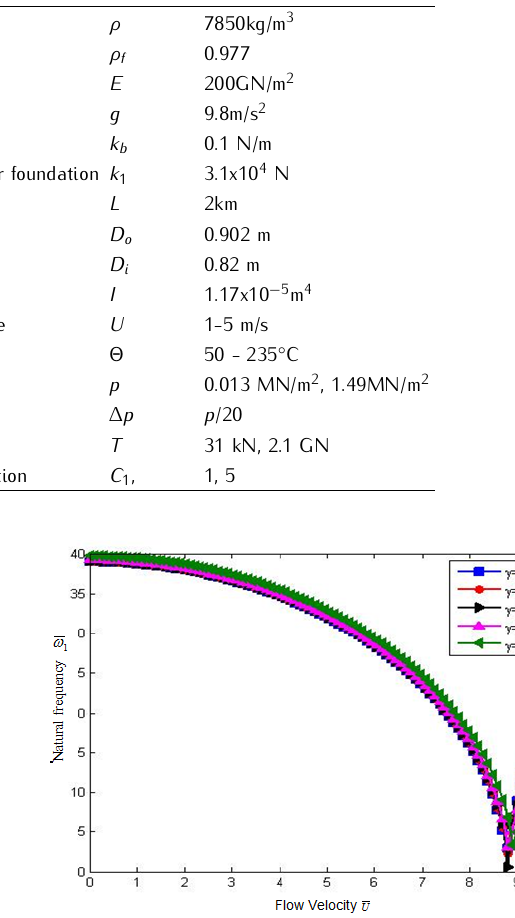
Figure 5. Absolute values of the transverse natural frequencies profile for the case R i = 0 . 41 m,L = 2 km,γ = 0 . 02 ,δ 0 . 3721 , Θ = 100 ◦ C